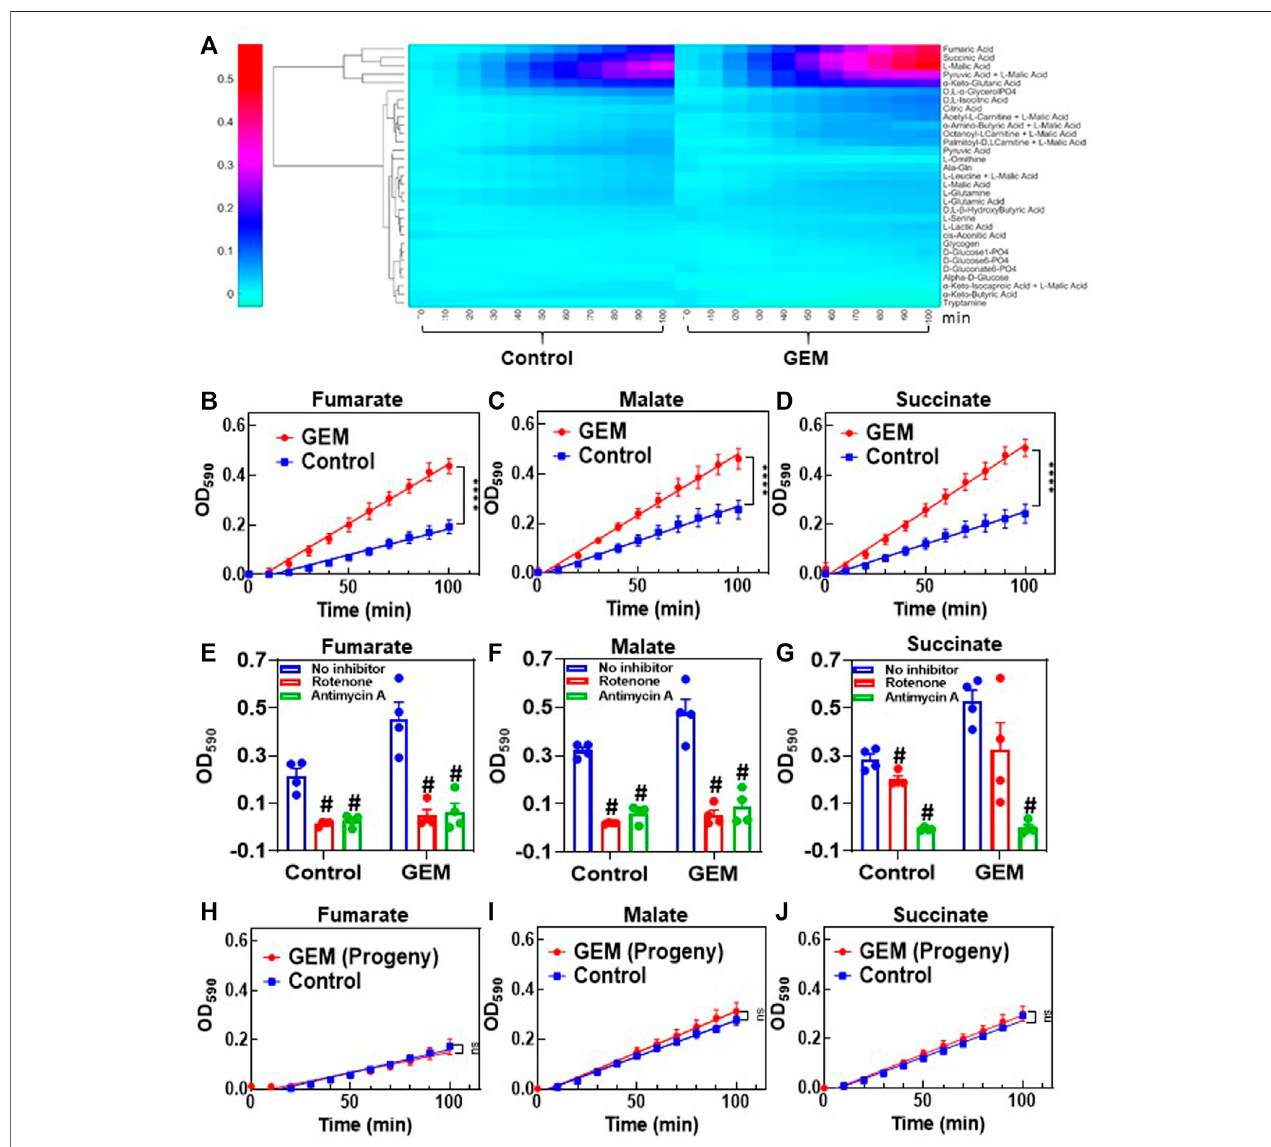
FIGURE 3 | Transient upregulation of Krebs cycle activity in GEM persisters: (A) Phenotype microarrays were used to assess the mitochondrial activities of GEM persister cells; 3 × 10 4 persister or untreated (control) A375 cells were transferred to each well of a phenotype microarray that also included a substrate and tetrazolium-based dye. The consumption rates of substrates were monitored by measuring the OD 590 at the indicated time points (for 100 min total). Unsupervised clustering of absorbance data was performed using MATLAB. N (cid:1) 4. (B – D) The consumption rates for the selected substrates (4 mM) (fumarate, malate and succinate) were measured with the modi fi ed MitoPlate assay (see Materials and Methods). Linear regression analysis was performed using F statistics with GraphPad Prism (**** p < 0.0001). N (cid:1) 4. (E – G) Bar graphs represent the OD 590 data of the modi fi ed MitoPlate assays for fumarate, malate and succinate and indicate their consumption rates at 100 min in the presence of rotenone (10 µM) or antimycin A (10 µM). N (cid:1) 4. Statistical signi fi cance was assessed by performing pair-wise t -test. # represents a signi fi cant difference between the inhibitor (rotenone or antimycin A) and “ no inhibitor ” groups ( p < 0.05). (H – J) Persister cells were transferred to fresh medium without GEM to stimulate resuscitation. After the third passage, the daughter cells were collected, and their consumption rates for fumarate, malate and succinate were measured with the modi fi ed MitoPlate assay. Untreated parental cells were used as a control. N (cid:1) 4; ns: the slopes are not signi fi cantly different.